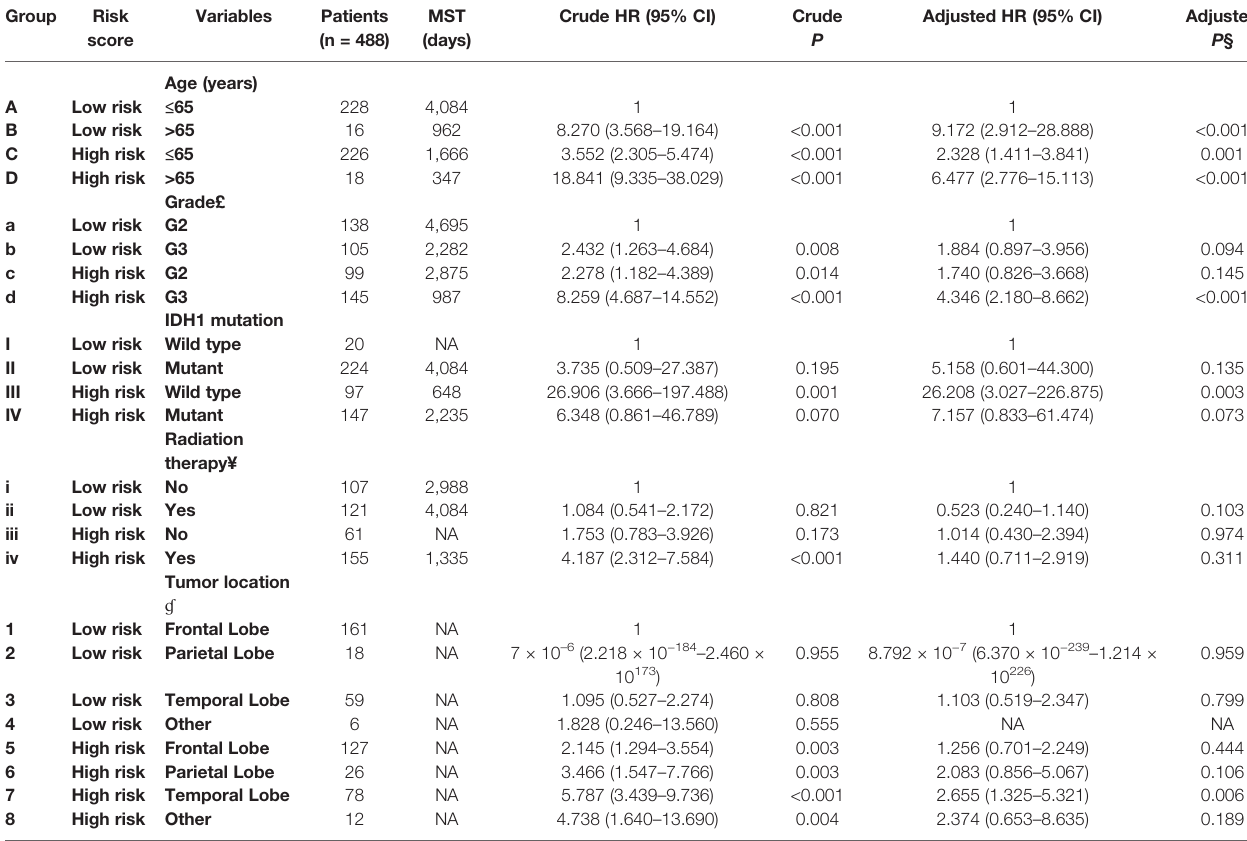
TABLE 2 | Joint effect survival analysis of the prognostic signature and clinical parameters with P < 0.01.